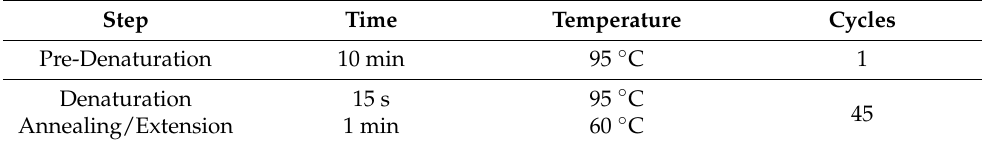
Table 2. qPCR Reaction Thermo